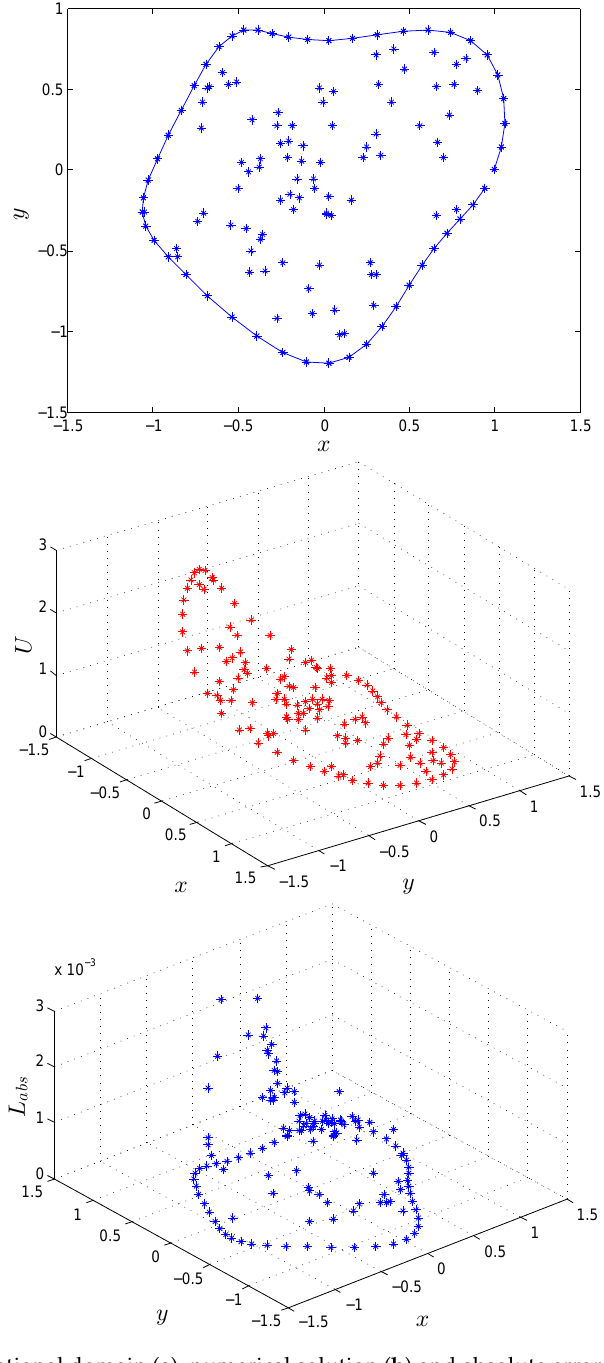
Figure 5. Computational domain ( a ), numerical solution ( b ) and absolute error ( c ) by using the EEM for Test Problem